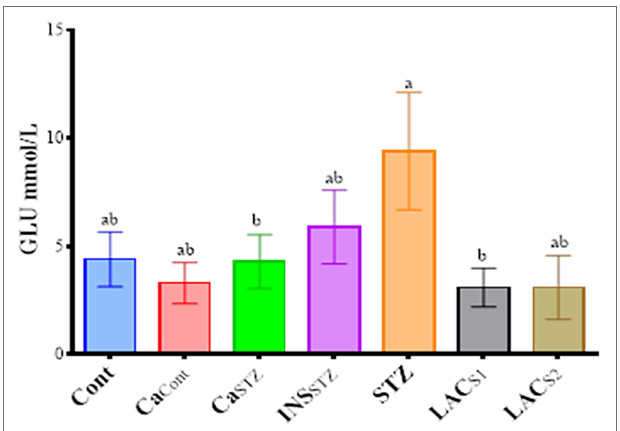
FIGURE 1 | Glucose levels (mmol/l) during 4 weeks. Cont , control; Ca Cont , camel milk control; Ca STZ , camel milk with streptozotocin; INS STZ , insulin with streptozotocin; STZ , streptozotocin; LAC SI , KLDS 1.0727 with streptozotocin;